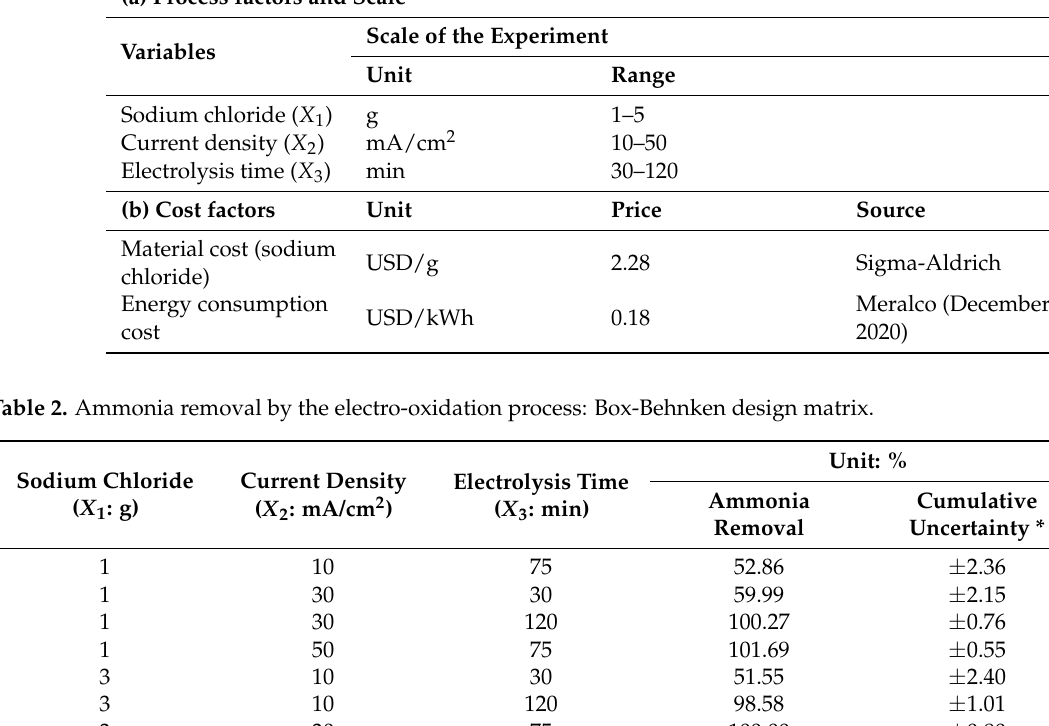
Table 1. ( a ) Process and ( b ) cost factors of the electrochemical oxidation of ammonia. (a) Process factors and Scale